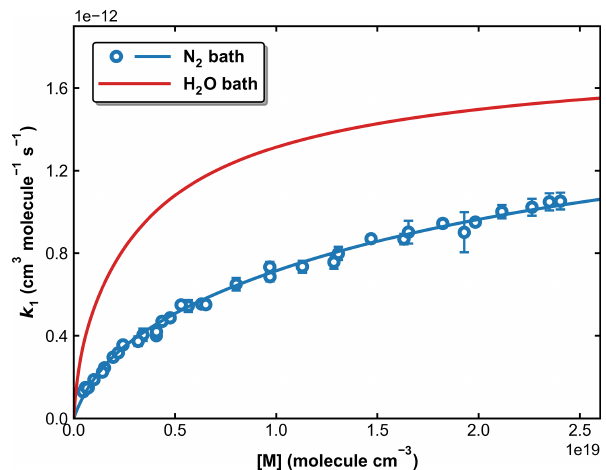
Figure 12. Fall-off curves for k 1 in N 2 and H 2 O bath gases at 298K. The solid lines are our preferred parameterization in N 2 –H 2 O bath 2 O with k 1 , ∞ = 2 . 0 × 10 − 12 cm 3 molecule − 1 s − 1 (independent of = 3 . 03 × 10 − 31 cm 6 molecule − 2 s − 1 , and k H 2 O = bath gas), k N 2 1 , 0 1 , 0 = F H 2 O = 0 . 1 . 65 × 10 − 30 cm 6 molecule − 2 s − 1 , F N 2 C C m = 0,